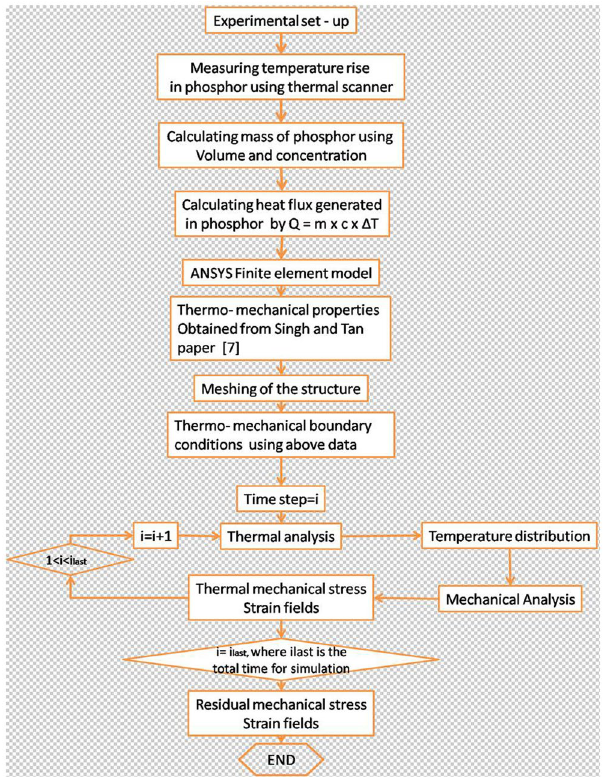
Figure 15. Flowchart for the ANSYS thermos-mechanical simulation to analyze the strain pattern and temperature flow in a packaged LED from our experimental results.